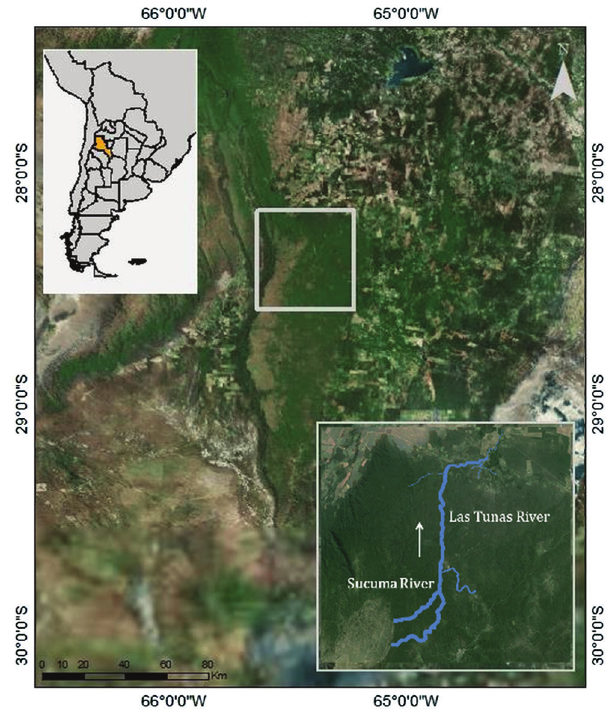
Fig. 4. Map of northwestern Argentina, showing the type locality of Astyanax powelli , Río Sucuma, Catamarca. Arrow indicates sense of flow.